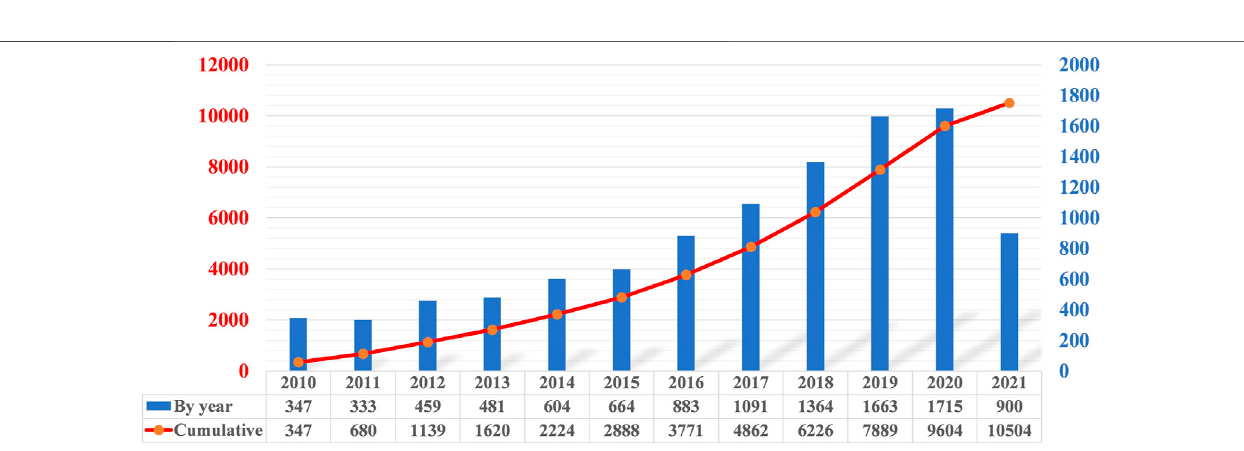
FIGURE 2 | The number of publications related to soft robotics by year and